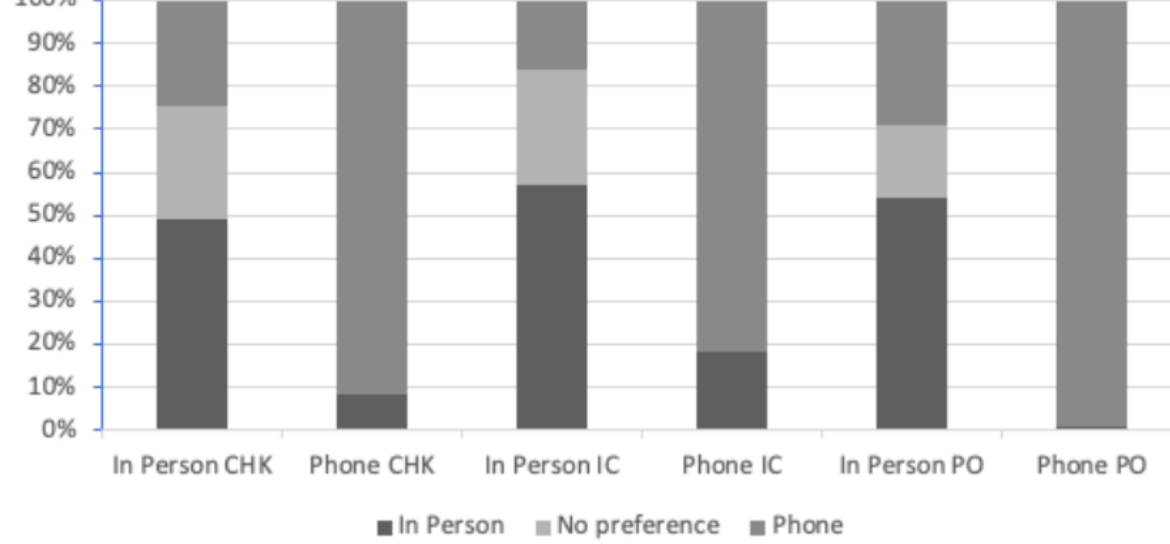
Figure 1. Preference for consultation by visit type. CHK: checkup; IC: initial consult; PO: postoperative.